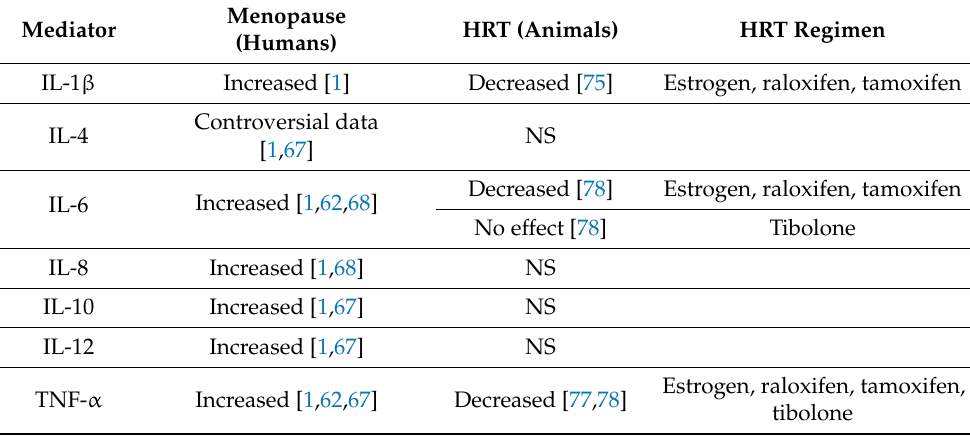
Table 2. Inflammatory molecule actions in animal studies in menopause and after HRT use in menopause (NS: not